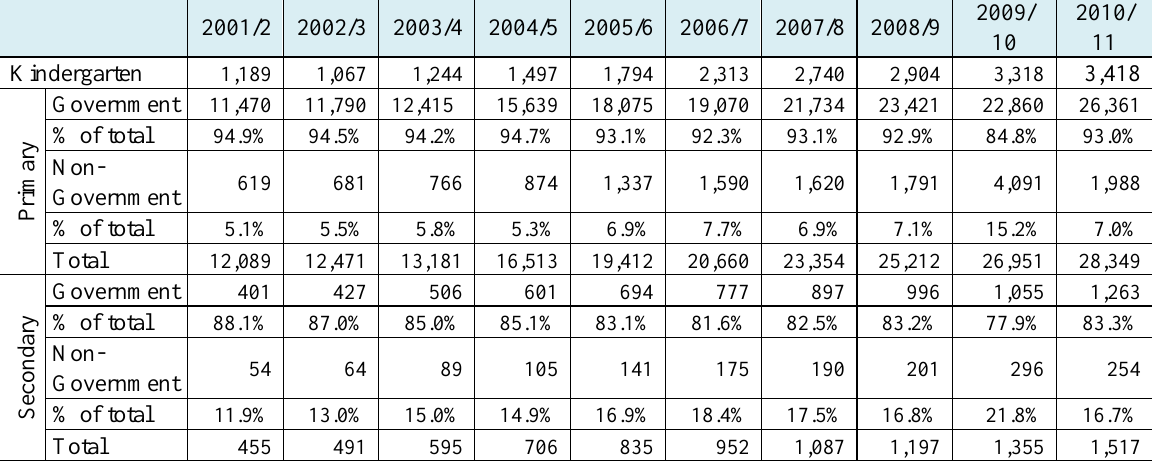
Table 4-2: Number of Kindergarten, Primary and Secondary Schools by